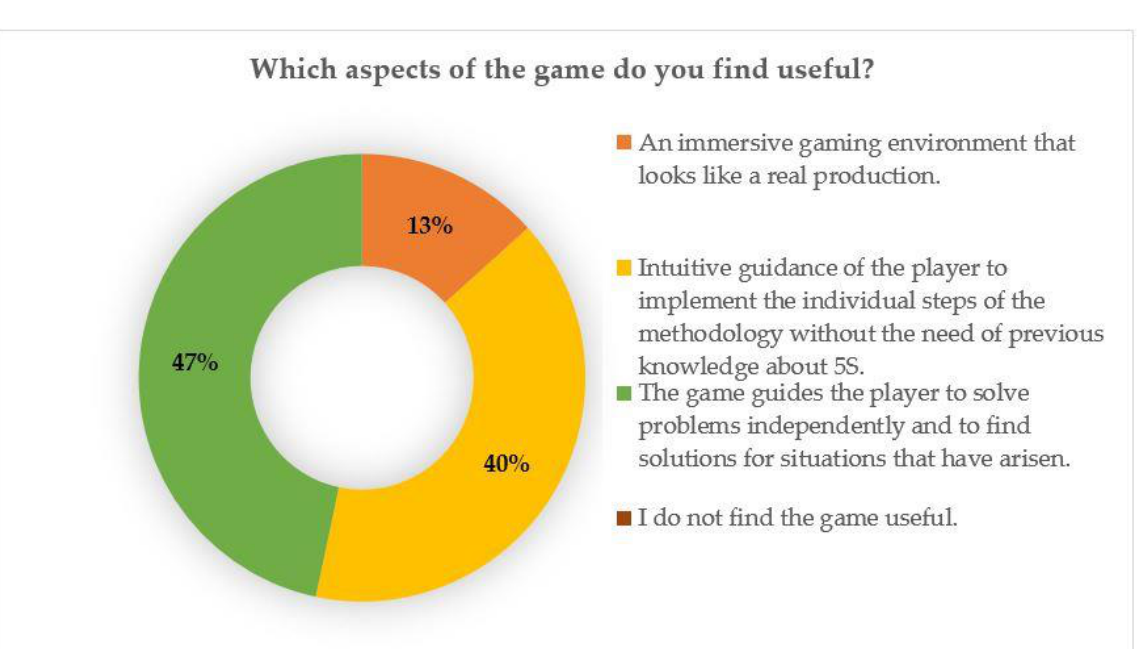
Figure 16. Subjective evaluation of the students’ comfort at individual levels.